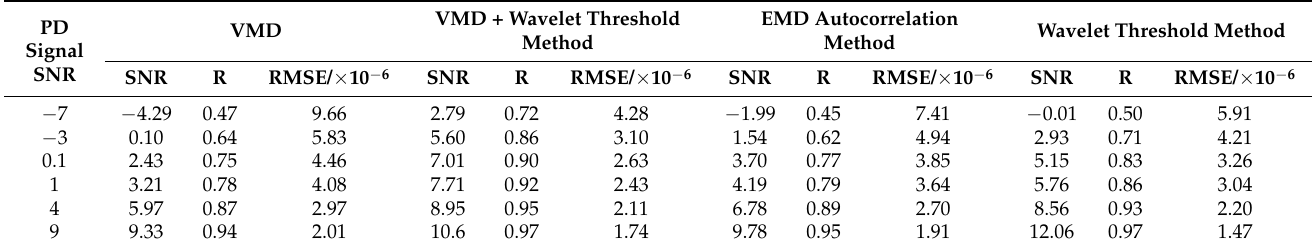
Table 1. Comparison of four ways to suppress the noise effect.